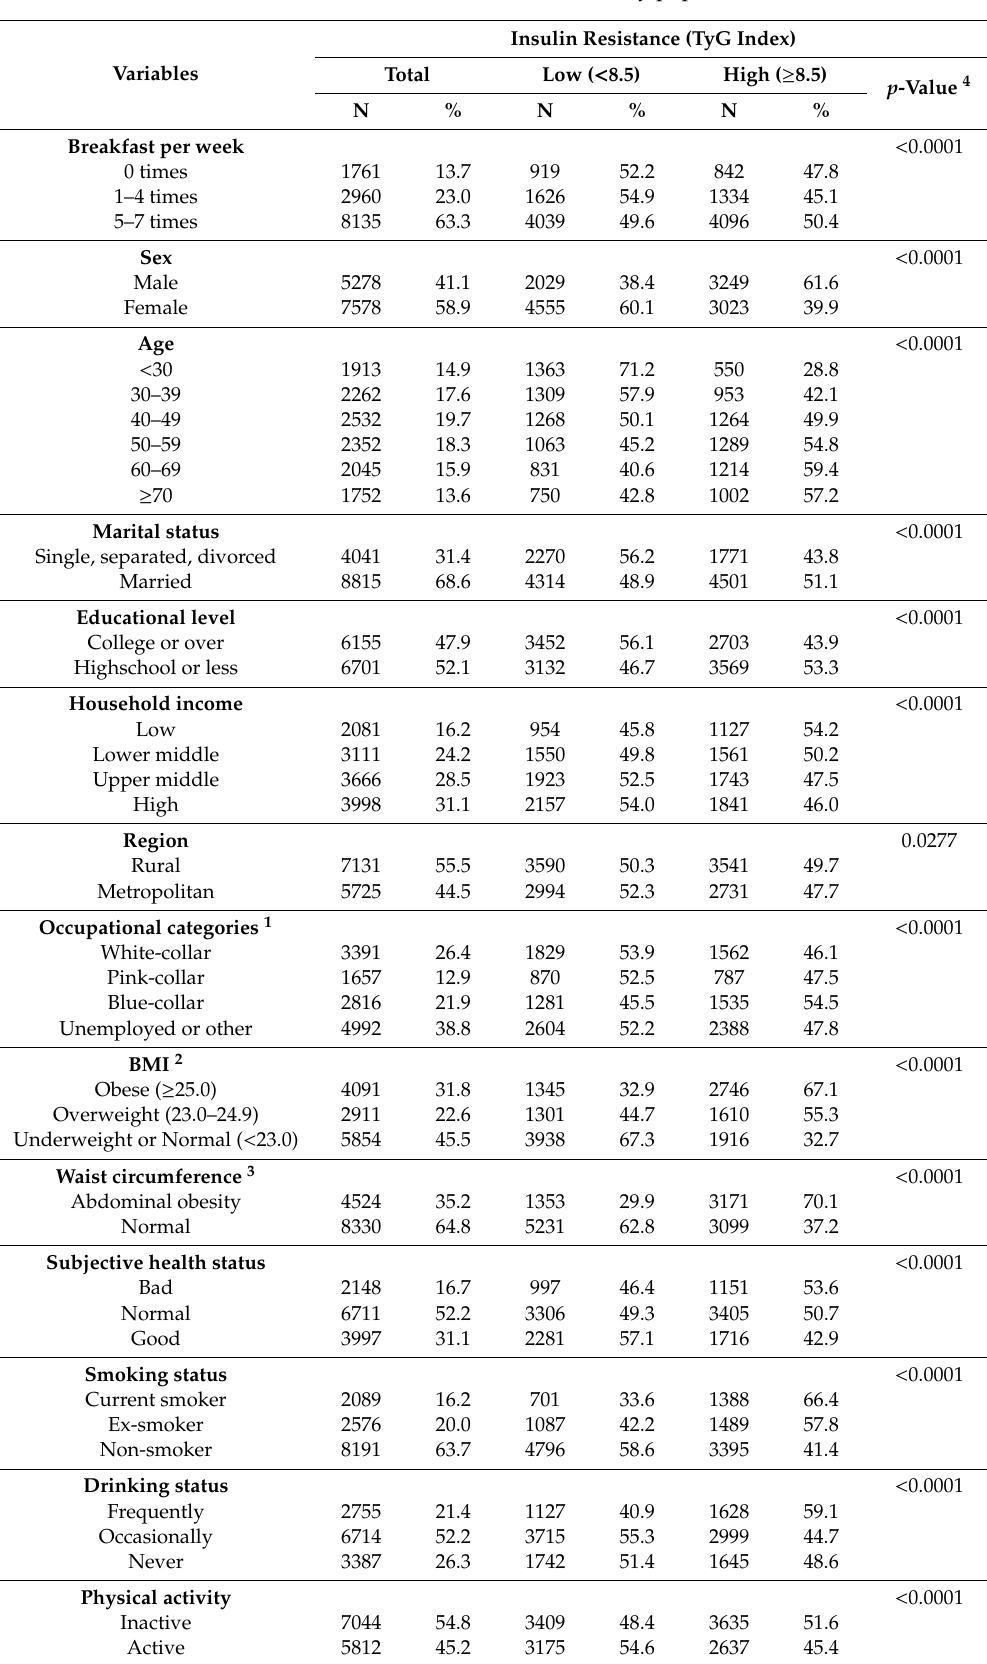
Table 1. General characteristics of the study